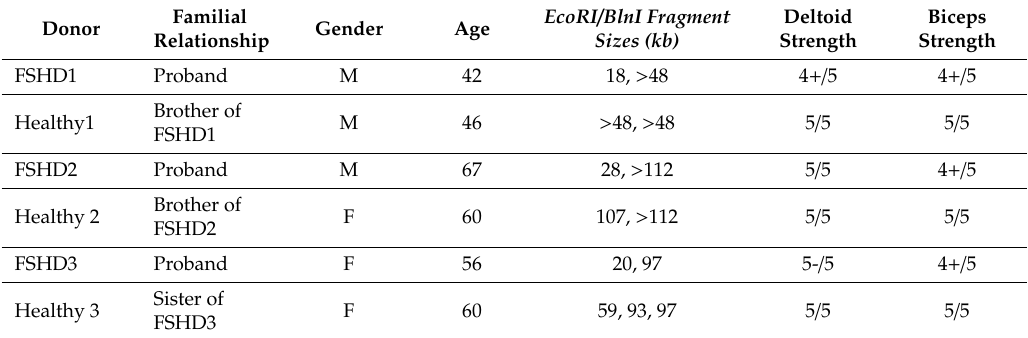
Table 1. Clinical Characteristics of Muscle Biopsy Donors. Information from Homma et al. (2012)